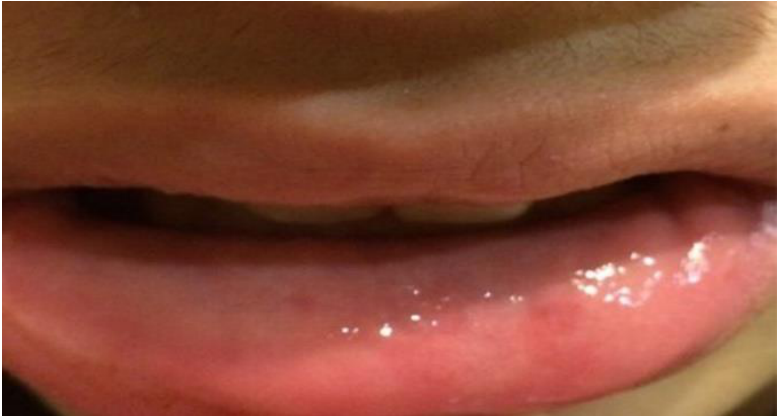
Figure 4. Twelve months follow up. The patient showed the labial mucosa of conformation and normal color, without any scars.